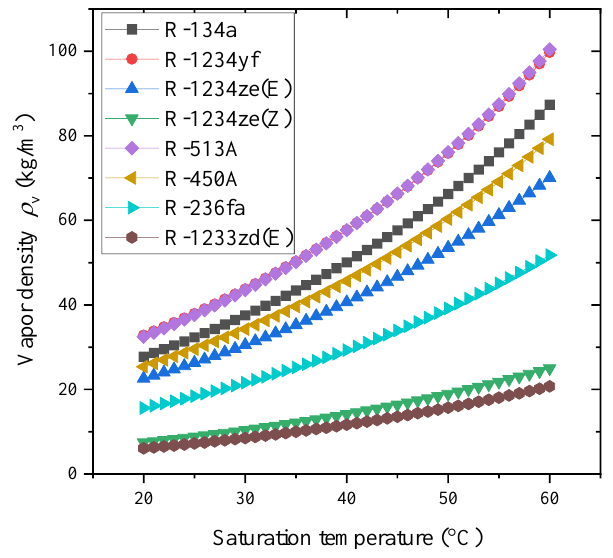
Figure 25. Saturation temperature versus vapor density of alternatives to R-134a [1].